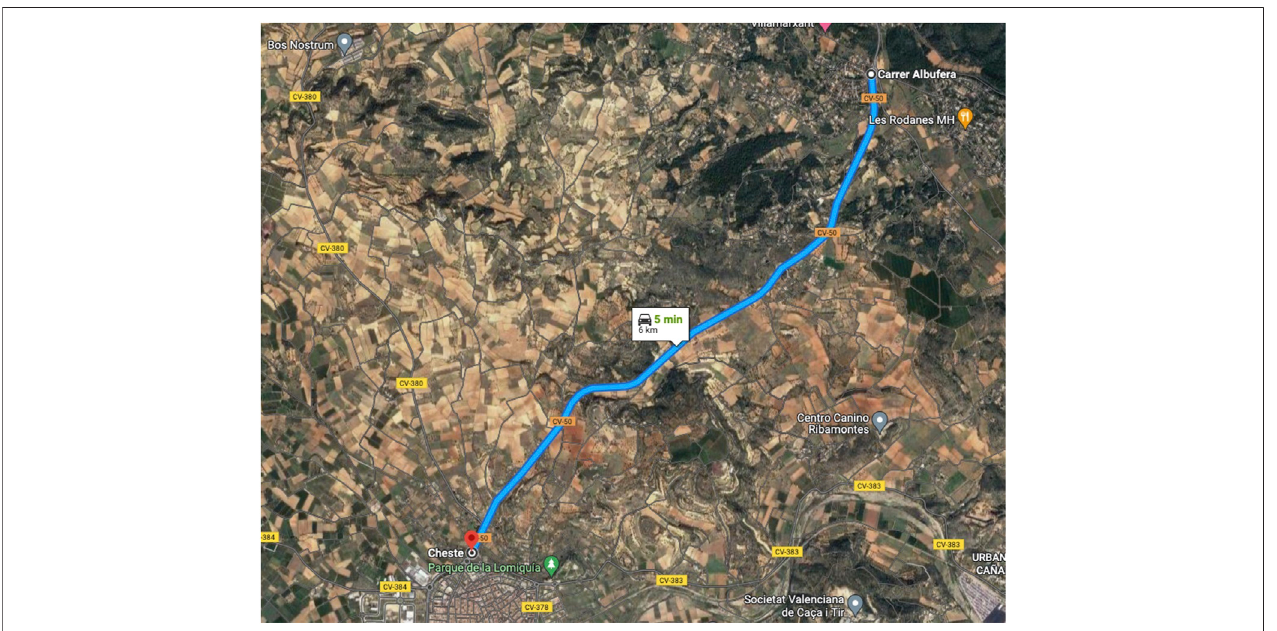
FIGURE 2 | Aerial view of the road segment. Map data: Google, Imagery ©2022 CNES/Airbus, European Space Imaging, Maxar Technologies. Map data ©2022 Inst. Geogr. Nacional.